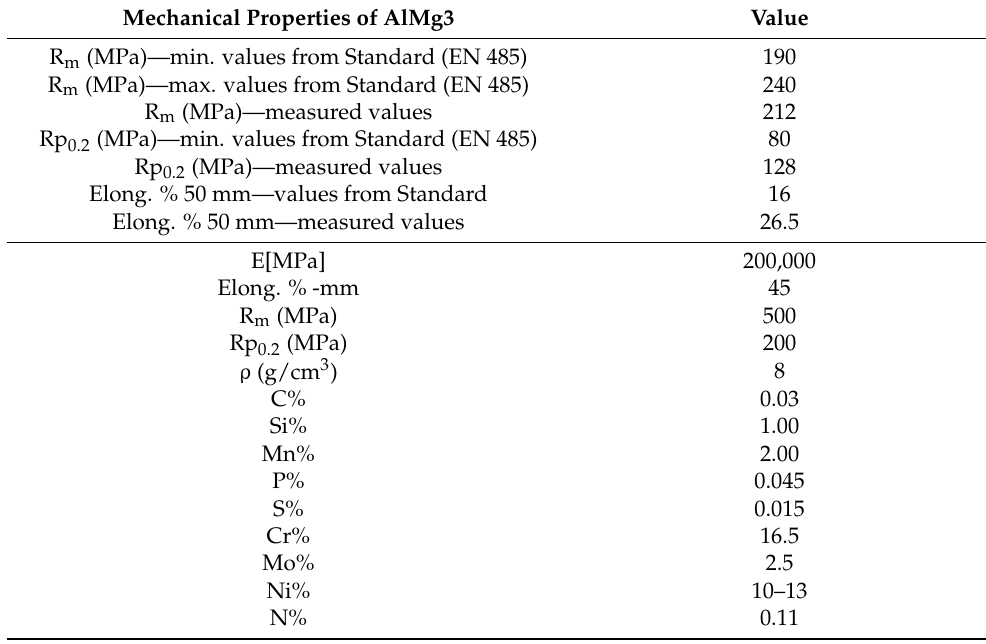
Table 2. Mechanical properties of AlMg3 and X2CrNiMo17-12-2 [11]. Mechanical Properties of AlMg3